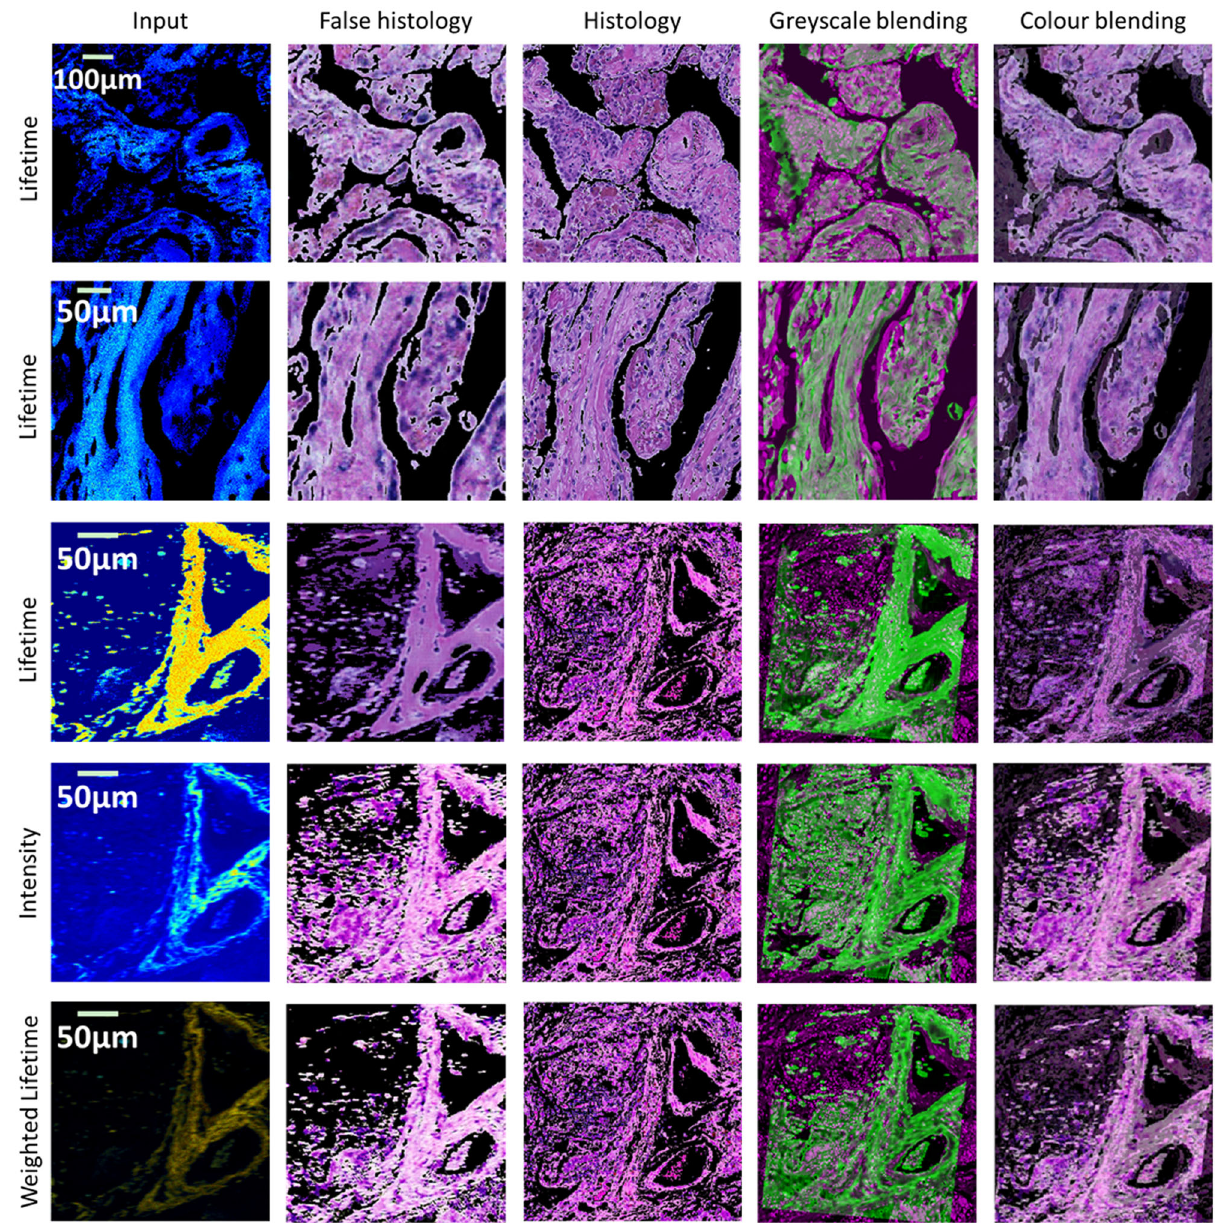
Fig. 2 Registration results with the proposed approach. All images are 256 × 256 in spatial resolution. The fi rst row is a lifetime image at wavelength 616 nm with a FOV 260 × 260 µ m. The second row is a lifetime image at wavelength 595 nm with a FOV 515 × 515 µ m. The rest of the three rows are a lifetime, intensity, and intensity-weighted lifetime image, respectively, at 690 nm with a FOV600 × 600 µ m. The generated false histology images are presented (second column), along with the interactively cropped histology patch (third column). Registration results are illustrated by combining the false and real histology images together, using greyscale (fourth column) and the original colour( fi fth column). To improve the visual interpretation, FLIM and histology images are visualised in green and magenta, respectively, in the greyscale blending (fourth